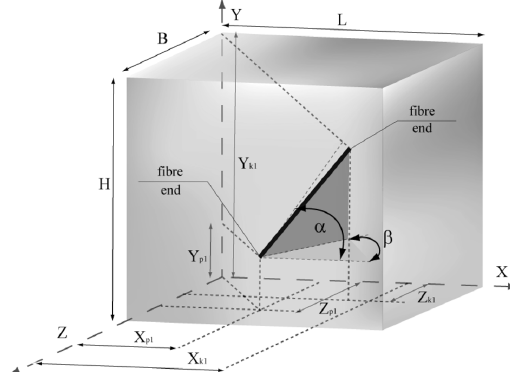
Fig. 2. The orientation of a single fibre with relation to the axis of the Cartesian